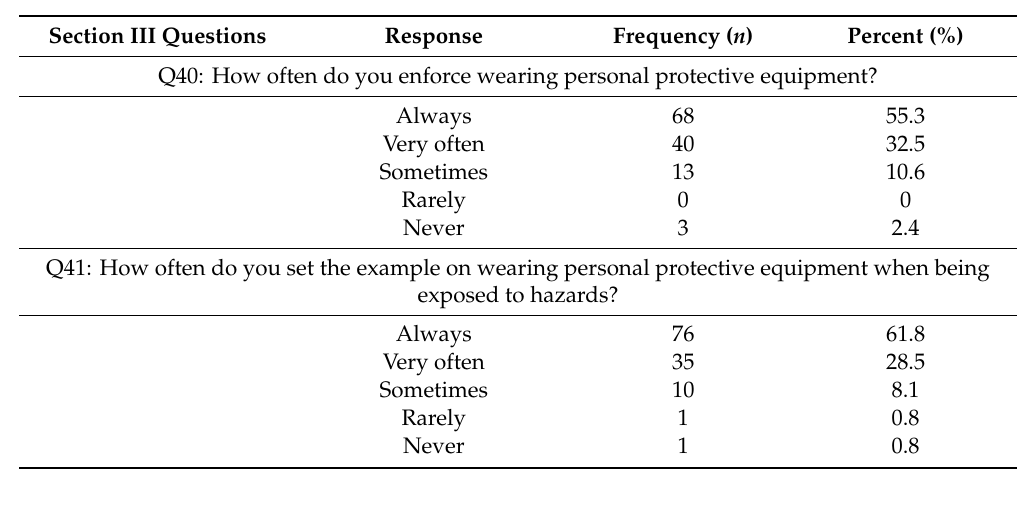
Table 4. Frequency of management beliefs, attitudes, and practices on enforcing PPE